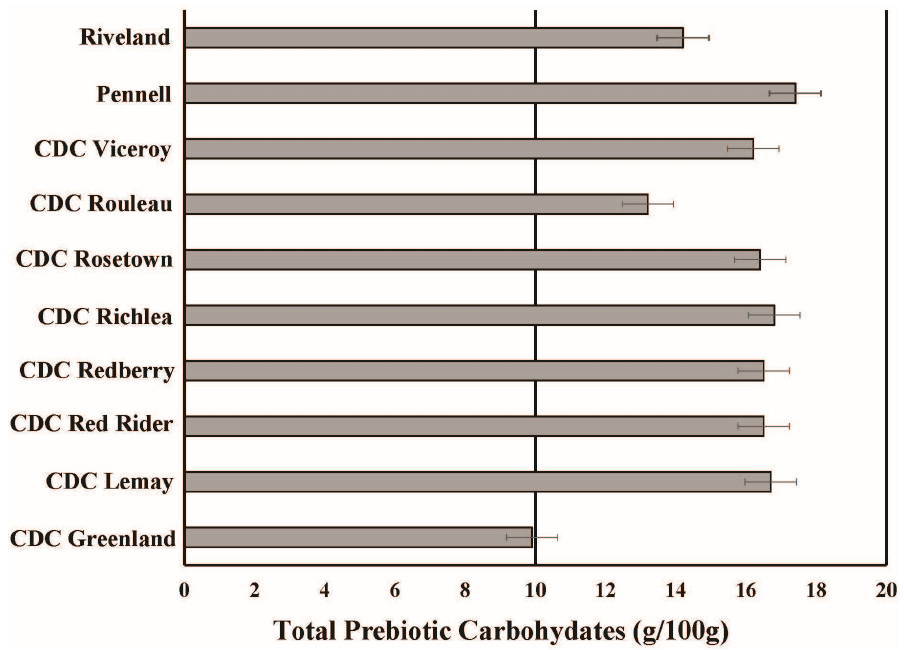
Figure 2. Concentrations of total prebiotic carbohydrates in a 100 g serving of different lentil cultivars grown the USA. Original data adopted from Johnson et al . (2013) [46]. Total prebiotics are the sum of sugar alcohols, raffinose oligosaccharides, fructooligosaccharides, and resistant starch. Recommendation for daily total prebiotic intake reported by Douglas and Sanders (2008) is 10–20 g per day [51].